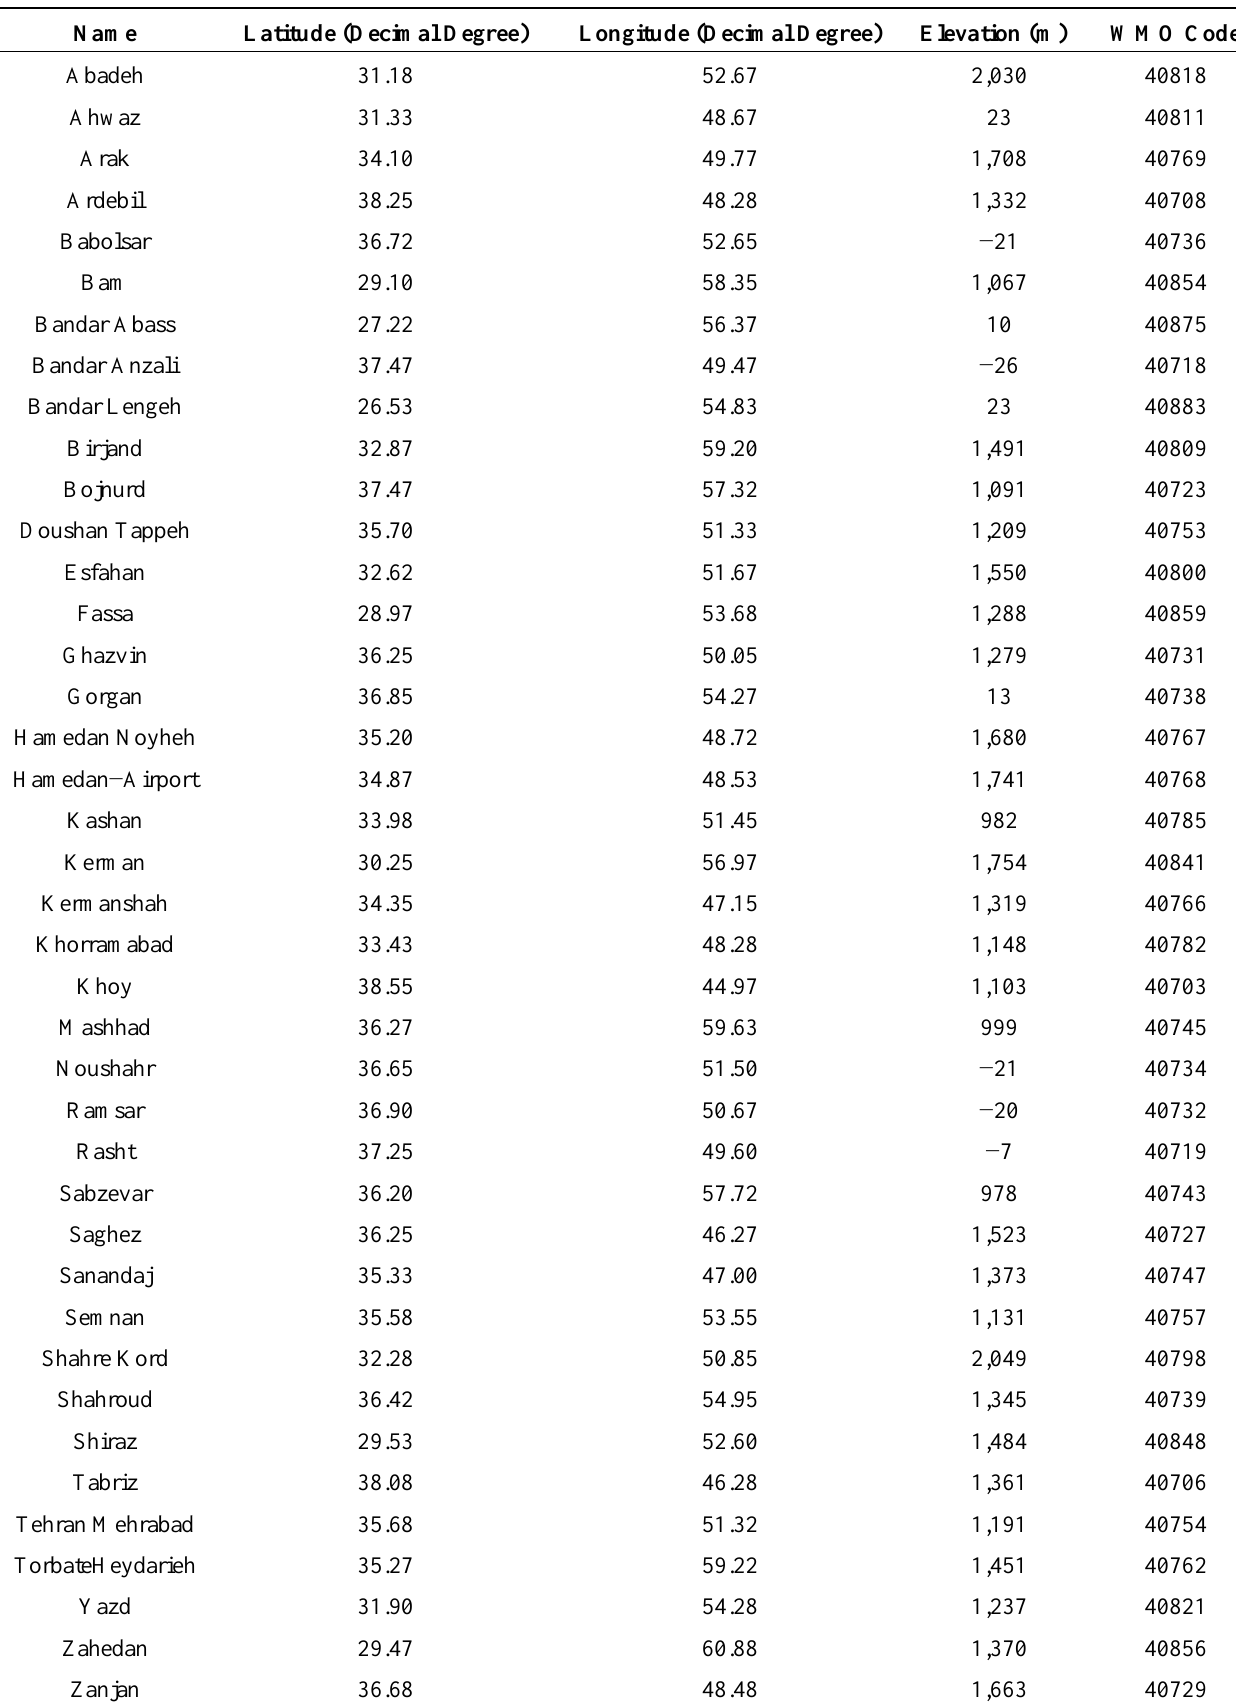
Table 2. List of selected meteorological